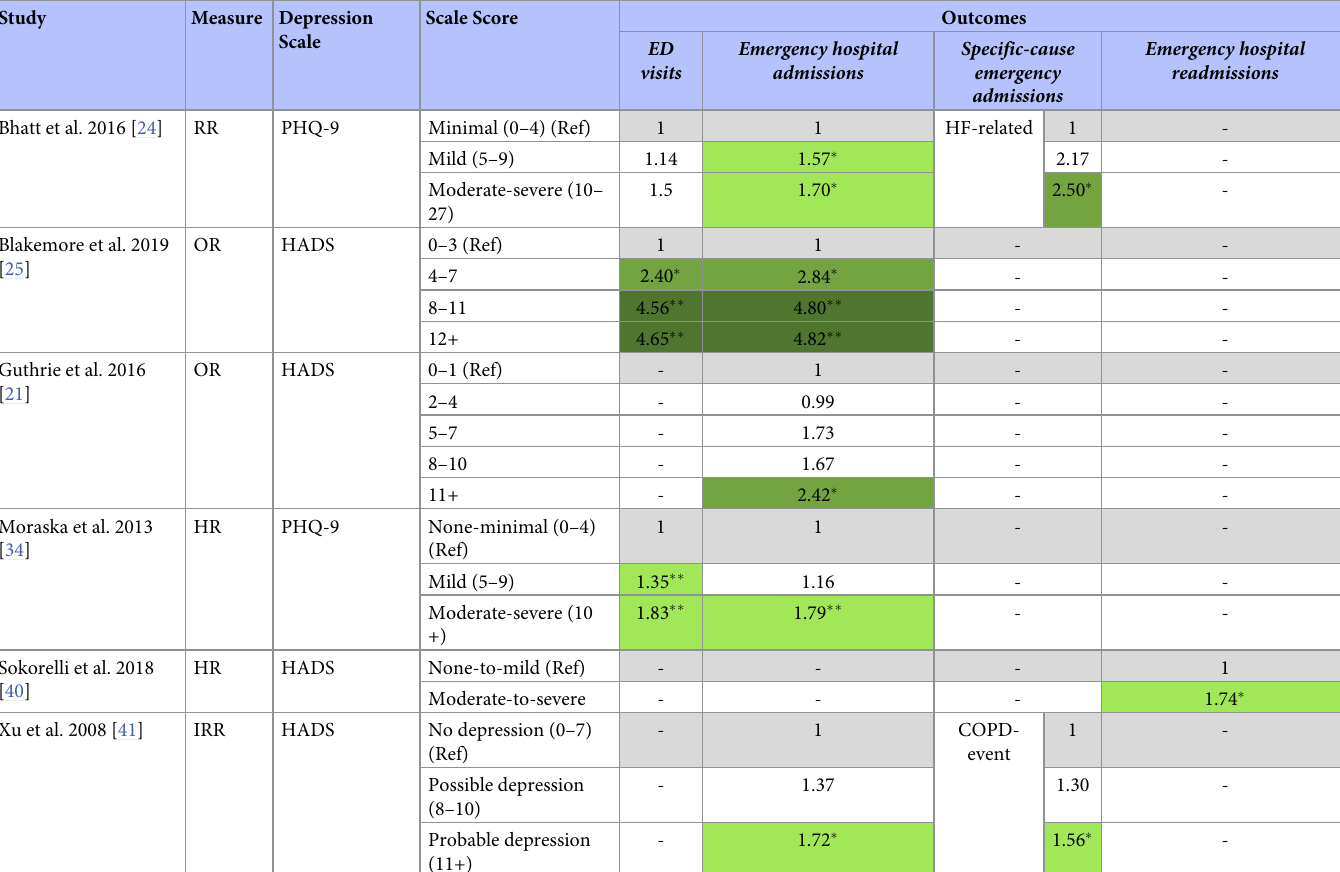
Table 2. Gradient of association between scale-based depression sub-groups and unplanned secondary healthcare outcomes. Study